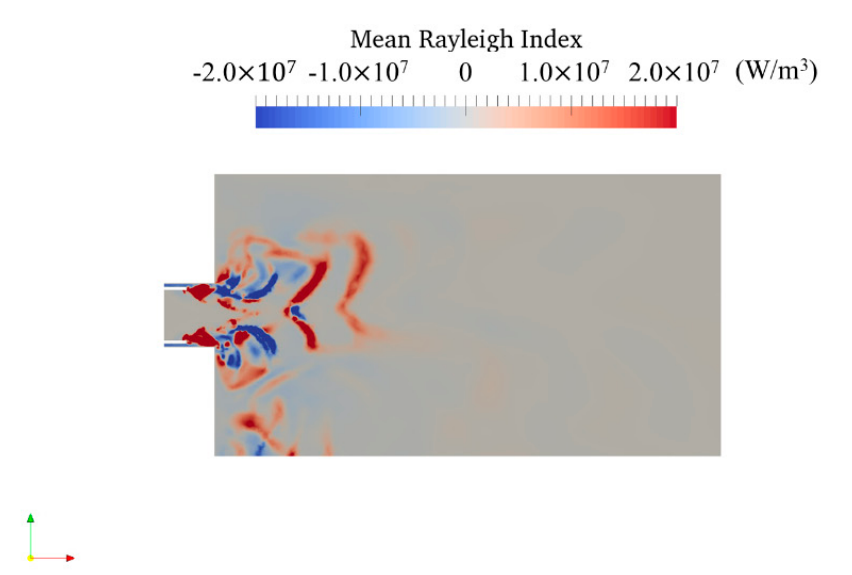
Figure 17. Phase-averaged Rayleigh index in the analysis plane of injector B for one period of the cycles.